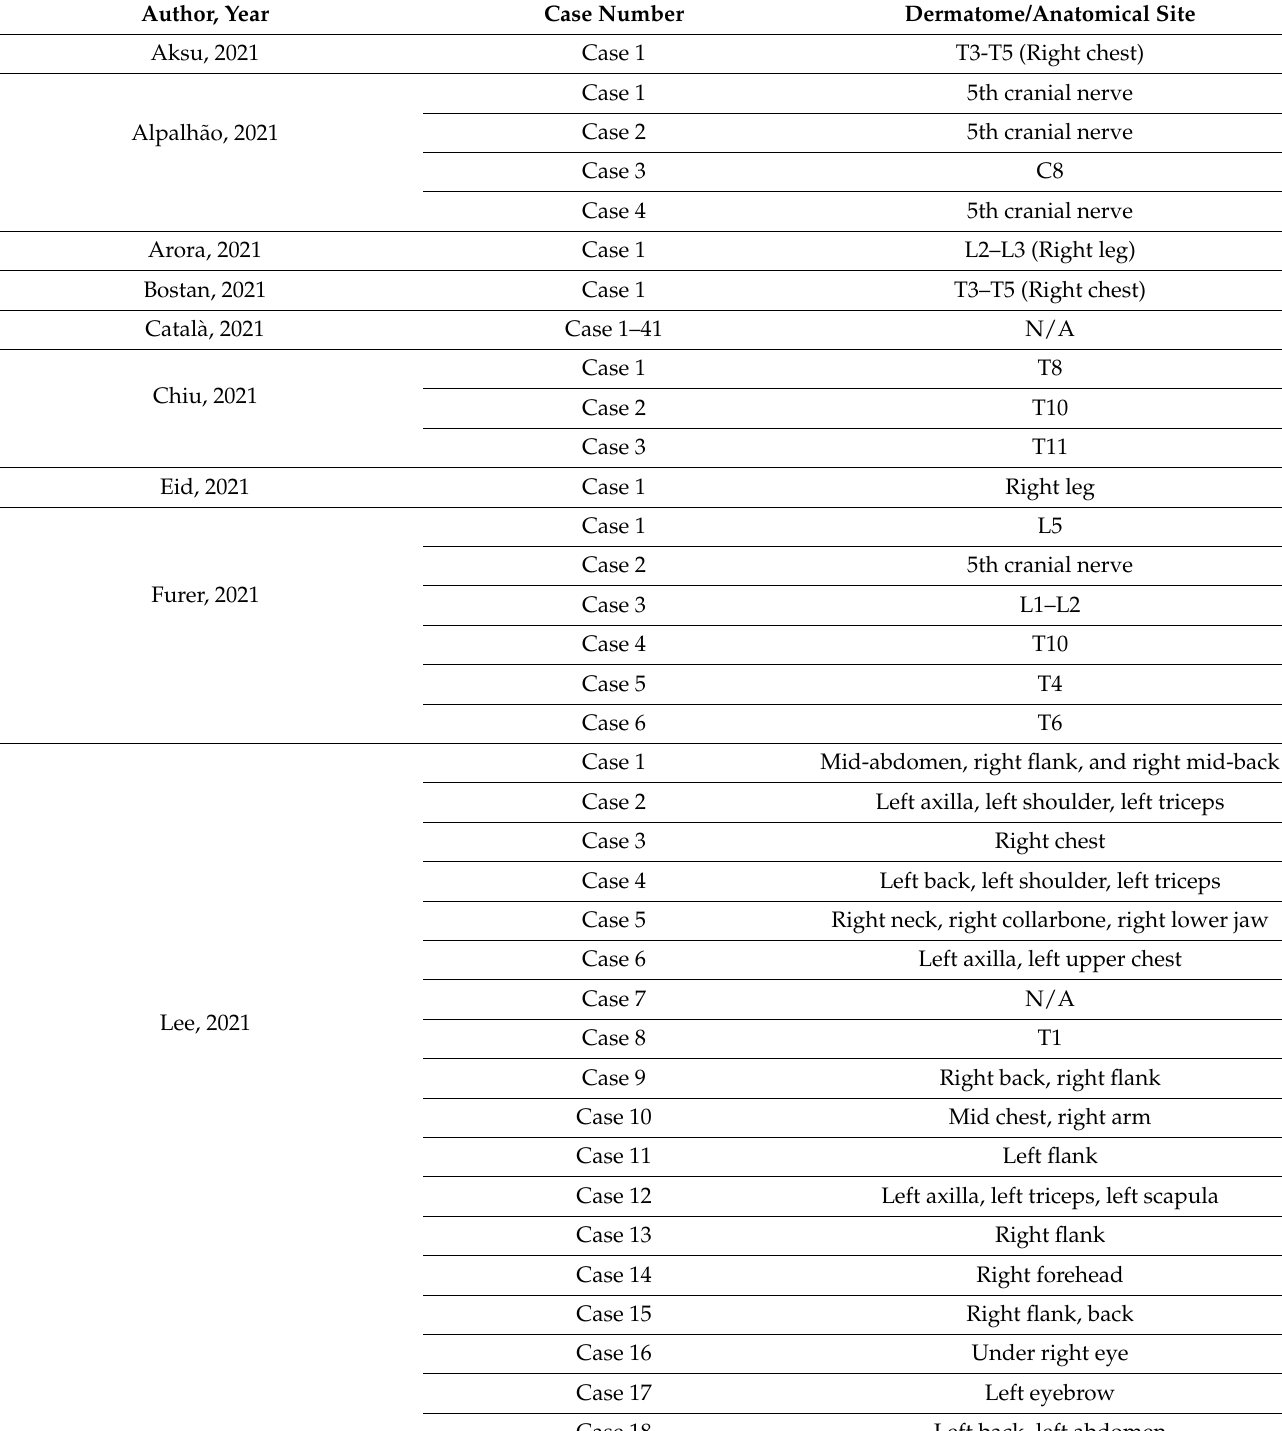
Table 2. Dermatome and anatomical site involvement in the reported HZ